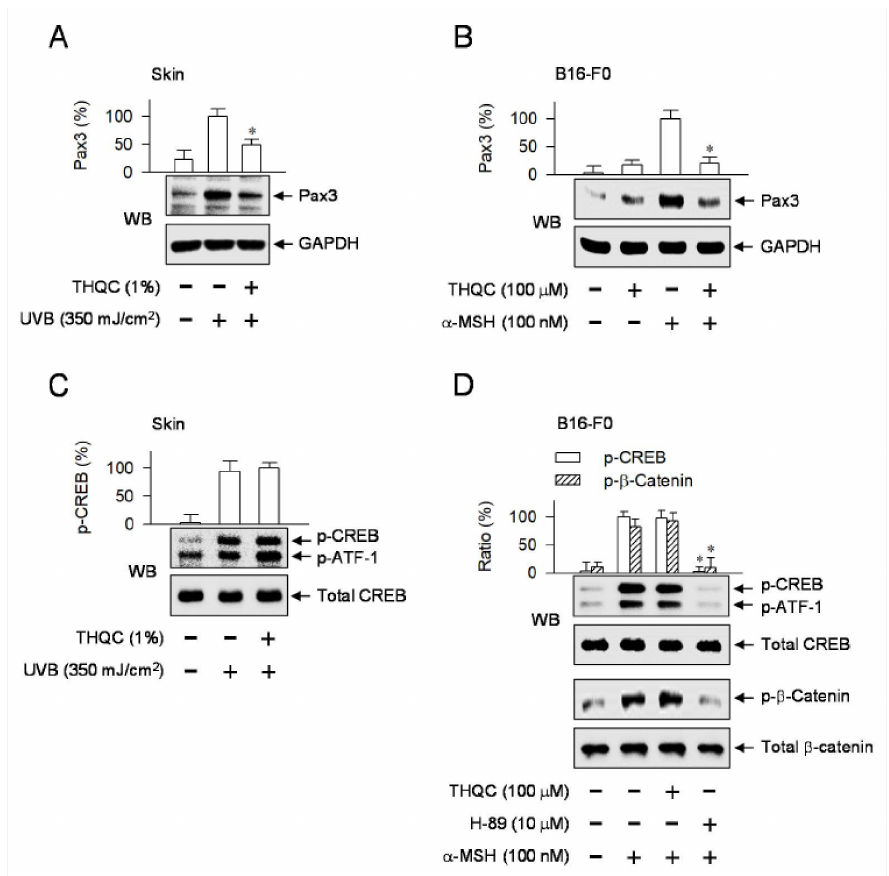
Figure 5. E ff ect of THQC on transcription factors regulating the MITF-M promoter. Transcription factors paired box gene 3 (Pax3), cAMP responsive element-binding protein (CREB), and β -catenin directly interact with the MITF-M promoter for transcriptional activation. The dorsal skin of guinea pig was irradiated with UVB and treated topically with THQC according to the protocol in Figure S1 (Supplementary Materials) ( A , C ). B16-F0 cells were pretreated with THQC for 2 h and stimulated with α -MSH for 2 h ( B ) or 15 min ( D ) in the presence of THQC. ( A ) Protein extract from skin tissue was resolved on SDS acrylamide gel by electrophoresis and subjected to Western blot analysis (WB) with anti-Pax3 or anti-GAPDH antibody. ( B ) Protein extract from B16-F0 culture was subjected to WB with anti-Pax3 or anti-GAPDH antibody. ( C ) Protein extract from skin tissue was subjected to WB with anti-phosphorylated (p)-CREB or anti-CREB antibody. ( D ) Protein extract from B16-F0 culture was subjected to WB with anti-p-CREB, anti-CREB, anti-p- β -catenin, or anti- β -catenin antibody. * p < 0.05 vs. UVB alone ( A ) or α -MSH alone ( B , D